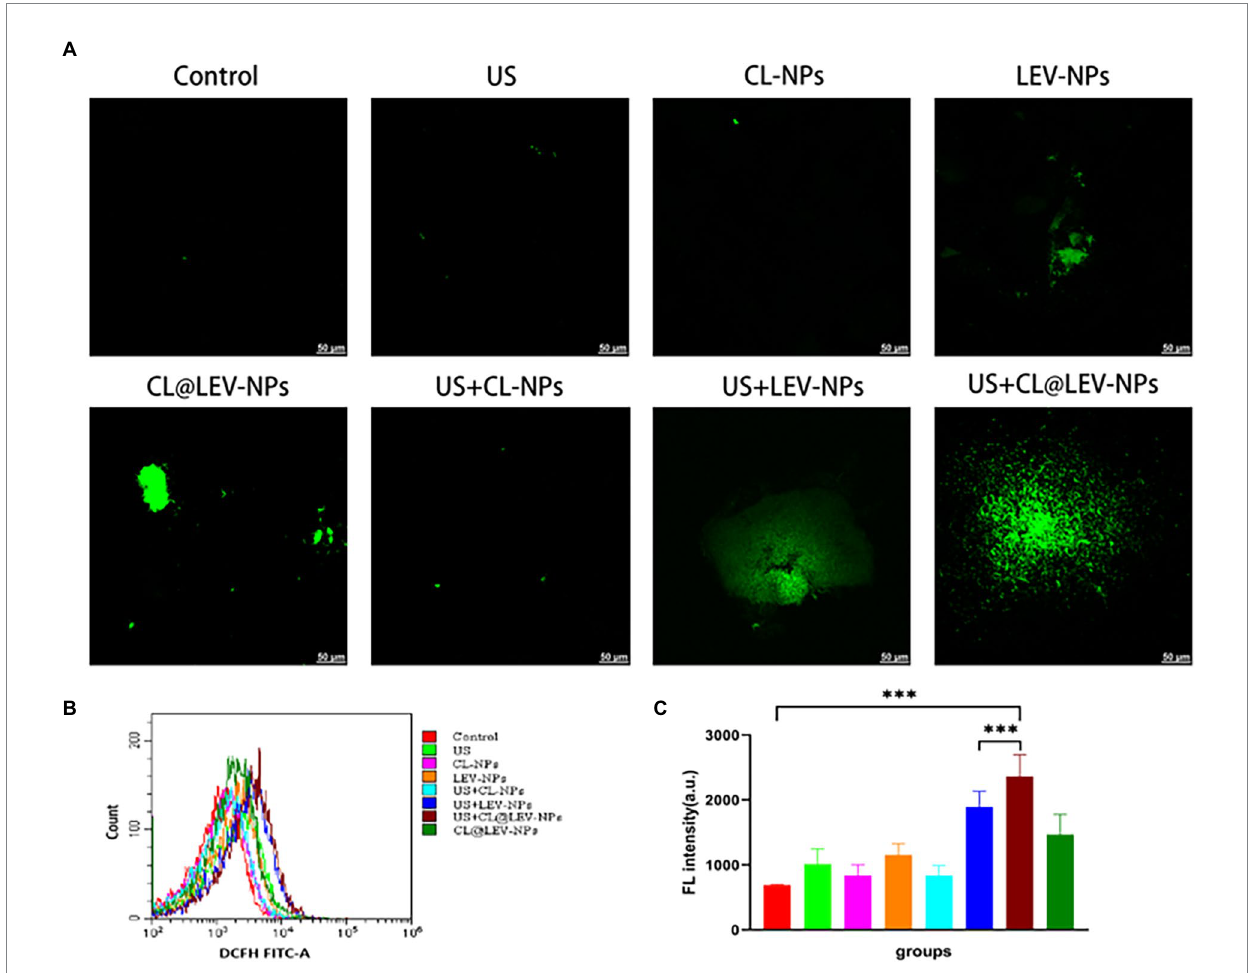
FIGURE 8 Determination of ROS production. (A) CLSM observation of reactive oxygen species in bacteria after different treatment of BCG biofilm in vitro , scale bar 50 μ m; (B) Flow cytometry to detect the mean fluorescence of DCFH-FITC-A after treatment of BCG biofilm in different ways; (C) Intensity quantitative analysis of ROS